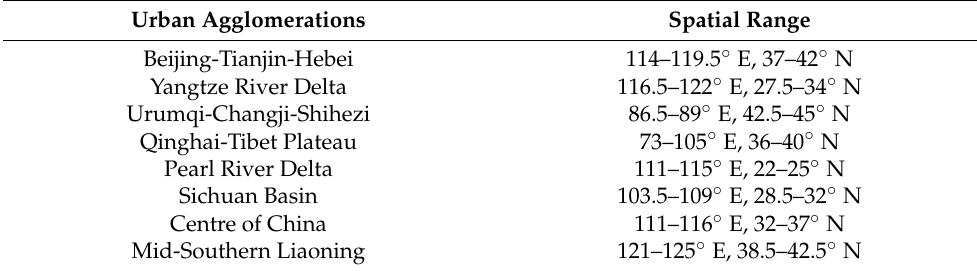
Table 1. Spatial ranges of the study